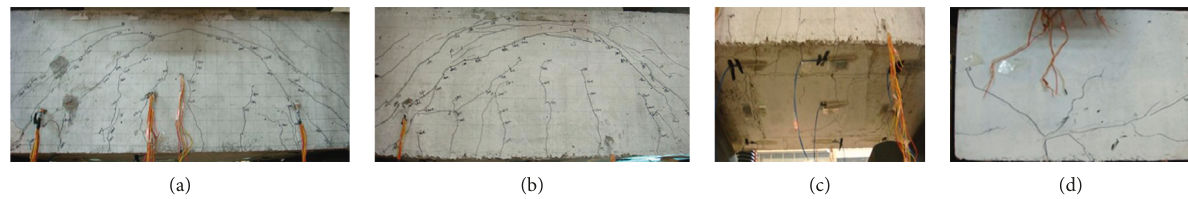
Figure 11: Main destruction of J-3 on the south side (a), on the north side (b), at the bottom of the specimen (c), and on the west side (d).